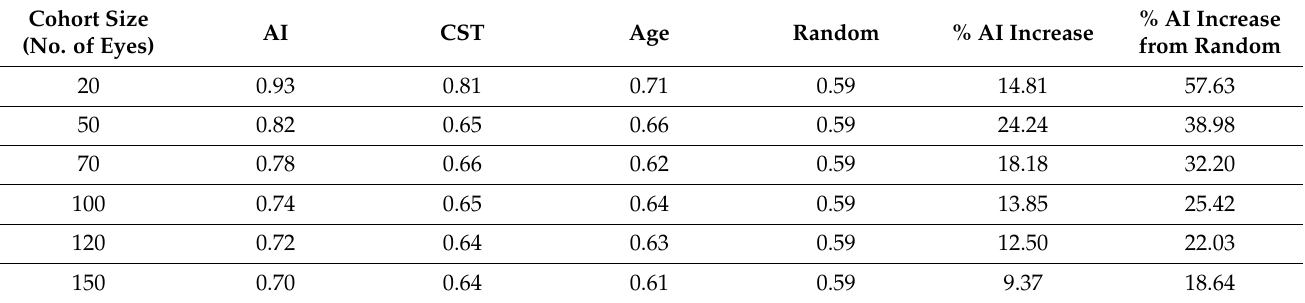
Table 4. Fraction of suboptimal responders for the standard protocol subcohort in selected trial